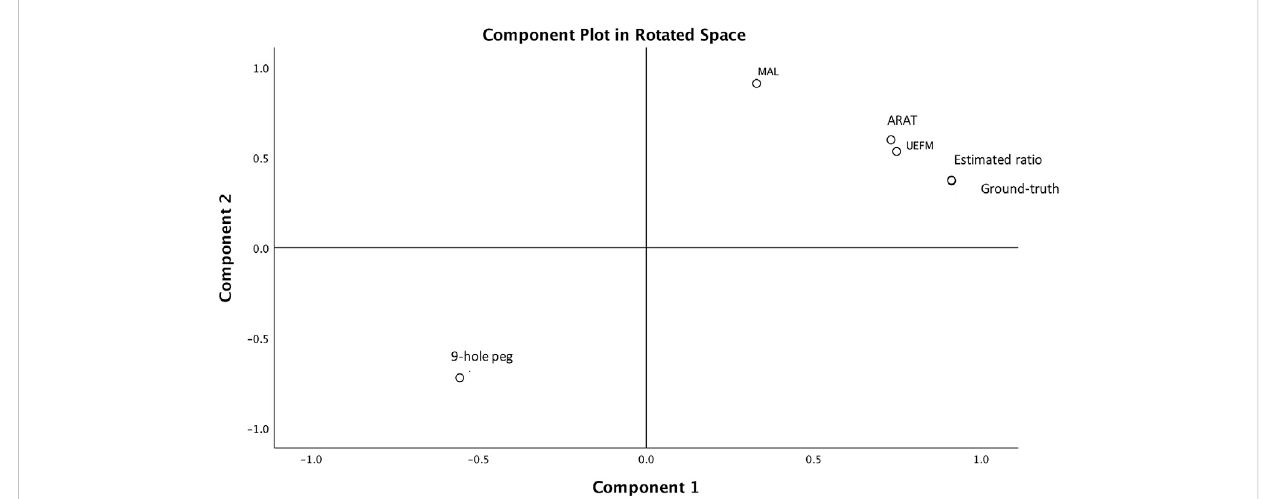
FIGURE 4 Componentplotinrotatedfactorspace.Asinglecomponentaccountsfor83%ofthevarianceinUEbehavioralmeasuresofUEFM,ARAT,nine-hole peg test, self-reported MAL, and the use ratios. This is evidenced on the component plot. Forcing a 2-component solution results in MAL and nine-hole peg test scores splitting from the UEFM, ARAT, and use ratios, evidenced by MAL falling closer to component 1 axis, as shown